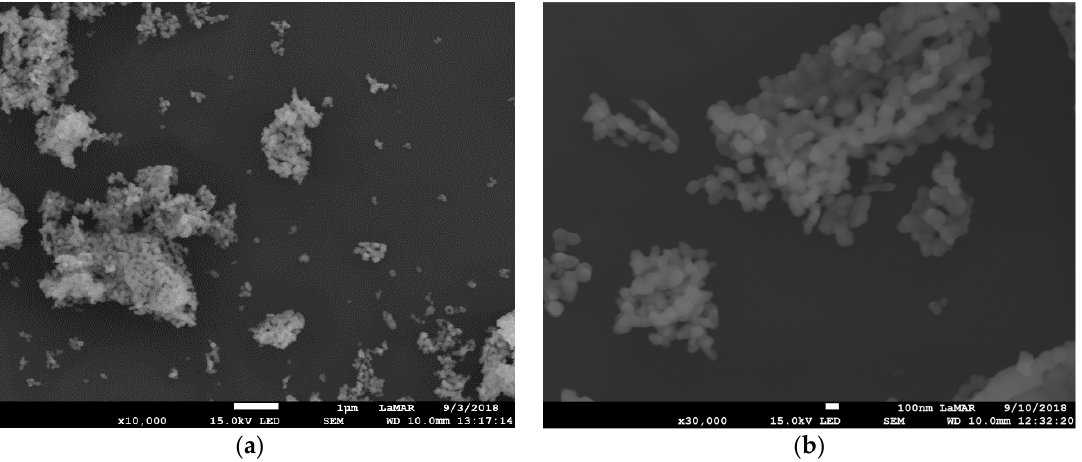
Figure 5. SEM image of Gd 2 O 3 :Eu 3+ nanoparticles at 10 4 times magnification ( a ) showing the aggregates of uniformly distributed nanoparticles and SEM image at 3 × 10 4 augmentation and ( b ) showing that the nanoparticles present an isotropic shape with a mean size of approximately 100 nm. The scale bar in ( a ) corresponds to 1 µ m and in ( b ) to 100 nm.